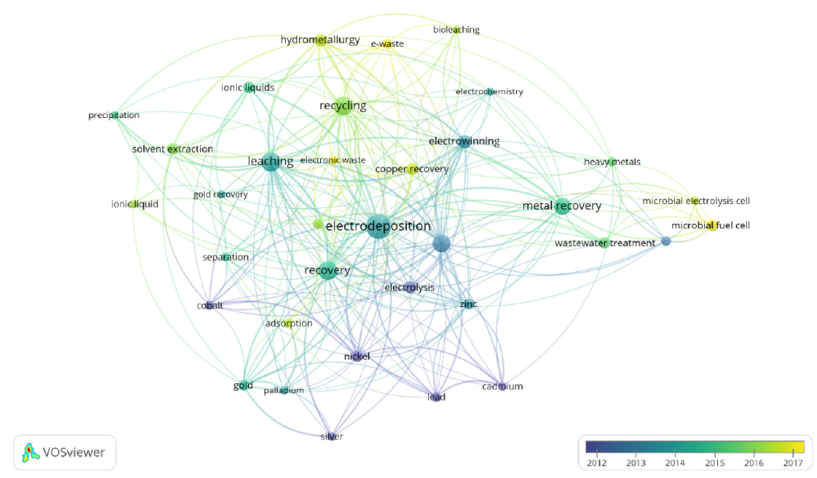
Figure 3. Keywords of papers published per year including the terms “electrodeposition” and “metal recovery”. Minimum number of keyword occurrence: 13. Figure made with the software VOSviewer .